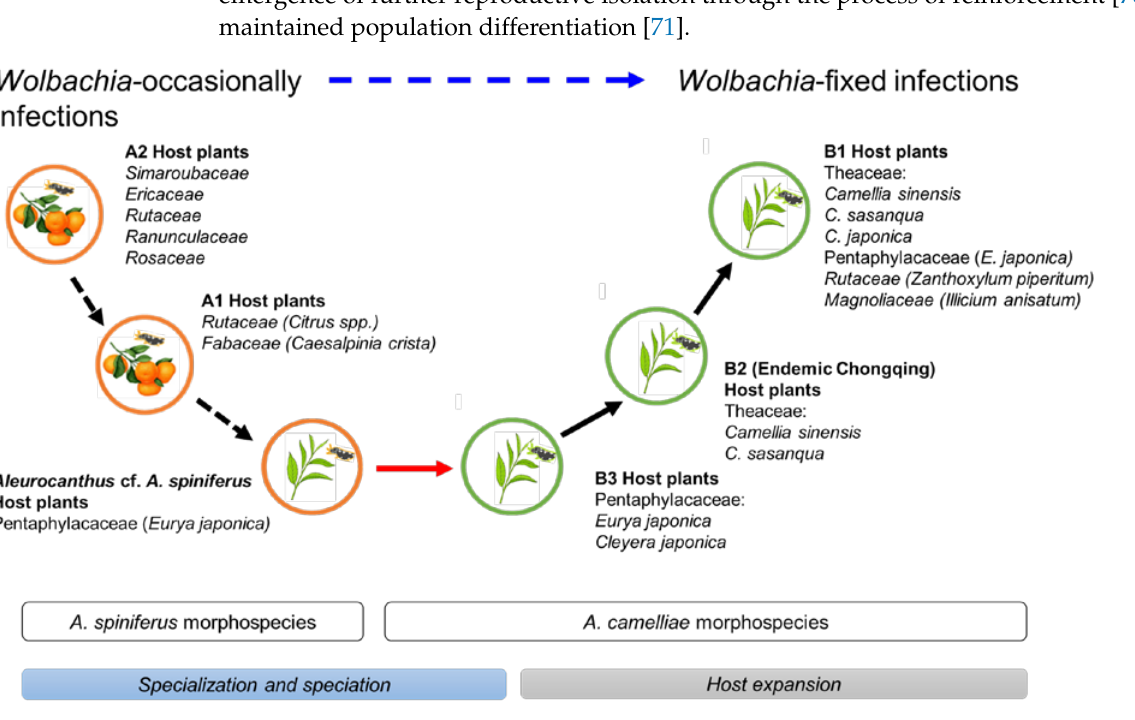
Figure 6. Hypothetical diagram of the evolutionary history of A. camelliae cryptic species. Predicted speciation time (see Figure 2) among A. spiniferus morphospecies occurred at the relatively same time (Rt 0.06) and was significantly separated from the predicted speciation time of A. camelliae morphospecies (Rt 0.01–0.02). The oscillation in the host plant range represents specialization (black-dashed arrow) and speciation (red arrow; blue bar) to host expansion (black arrow; gray bar). The hierarchical infection status of Wolbachia might be associated with the morphospecies (blue-dashed arrow).